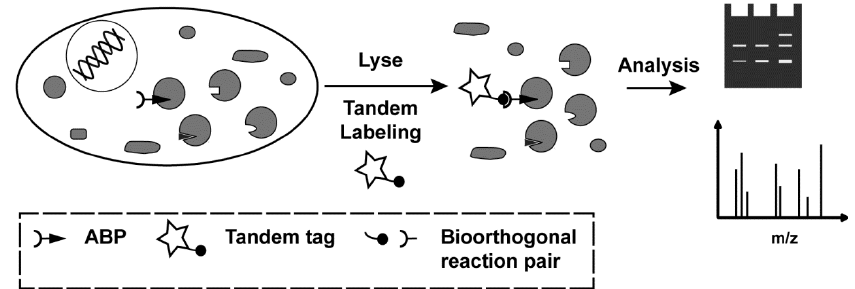
Figure 1. Schematic representation of tandem ABPP as site specific and activity-based technique to covalently tag active enzymes in situ and in vivo . A small molecule ABP equipped with one partner of a bioorthogonal reaction pair forms a covalent bond with active site residues of a subset of enzymes in a cell. After lysis, tandem labeling, such as click chemistry, introduces a tagging moiety on the enzyme-ABP complex. Depending on the tag, different analysis methods can be used, such as in-gel scanning, or affinity enrichment with mass spectrometry